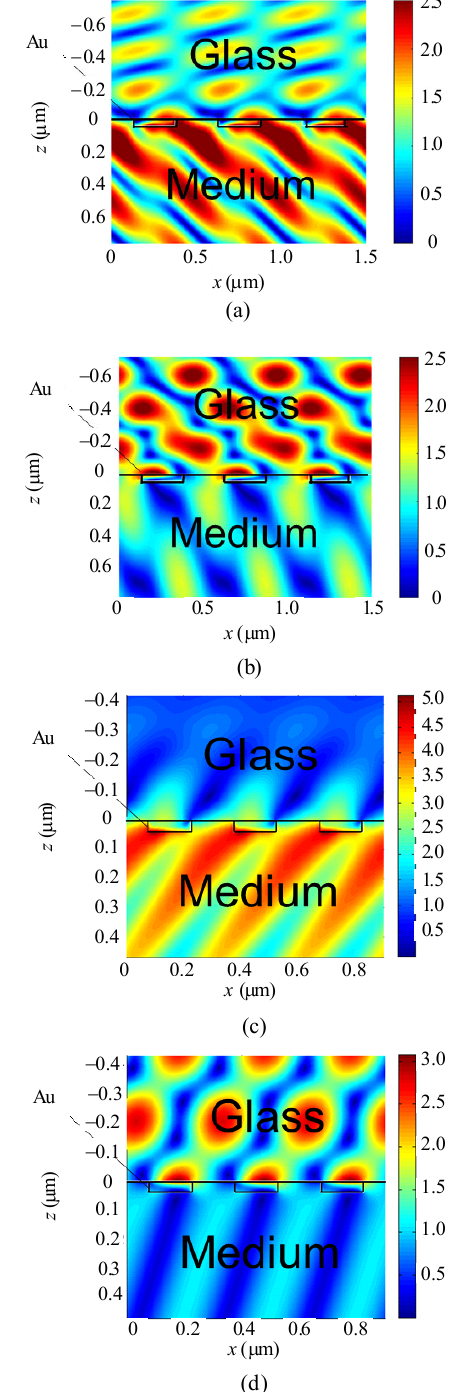
Fig. 3 Distribution of the magnetic field in the case of a mixed solution of 1-iodonaphthalene and sulfur: (a) grid period of 500 nm at 17.35 ° , (b) grid period of 500 nm at 7.15 ° , (c) grid period of 300 nm at 16.60 ° , and (d) grid period of 300 nm at 27.35 ° .